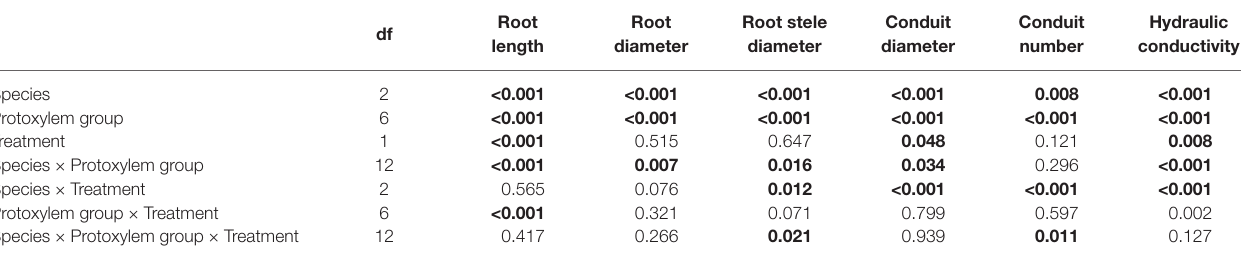
TABLE 1 | Results of three-way (species × protoxylem group × treatment) factorial ANOVA of root morphological and anatomical traits.